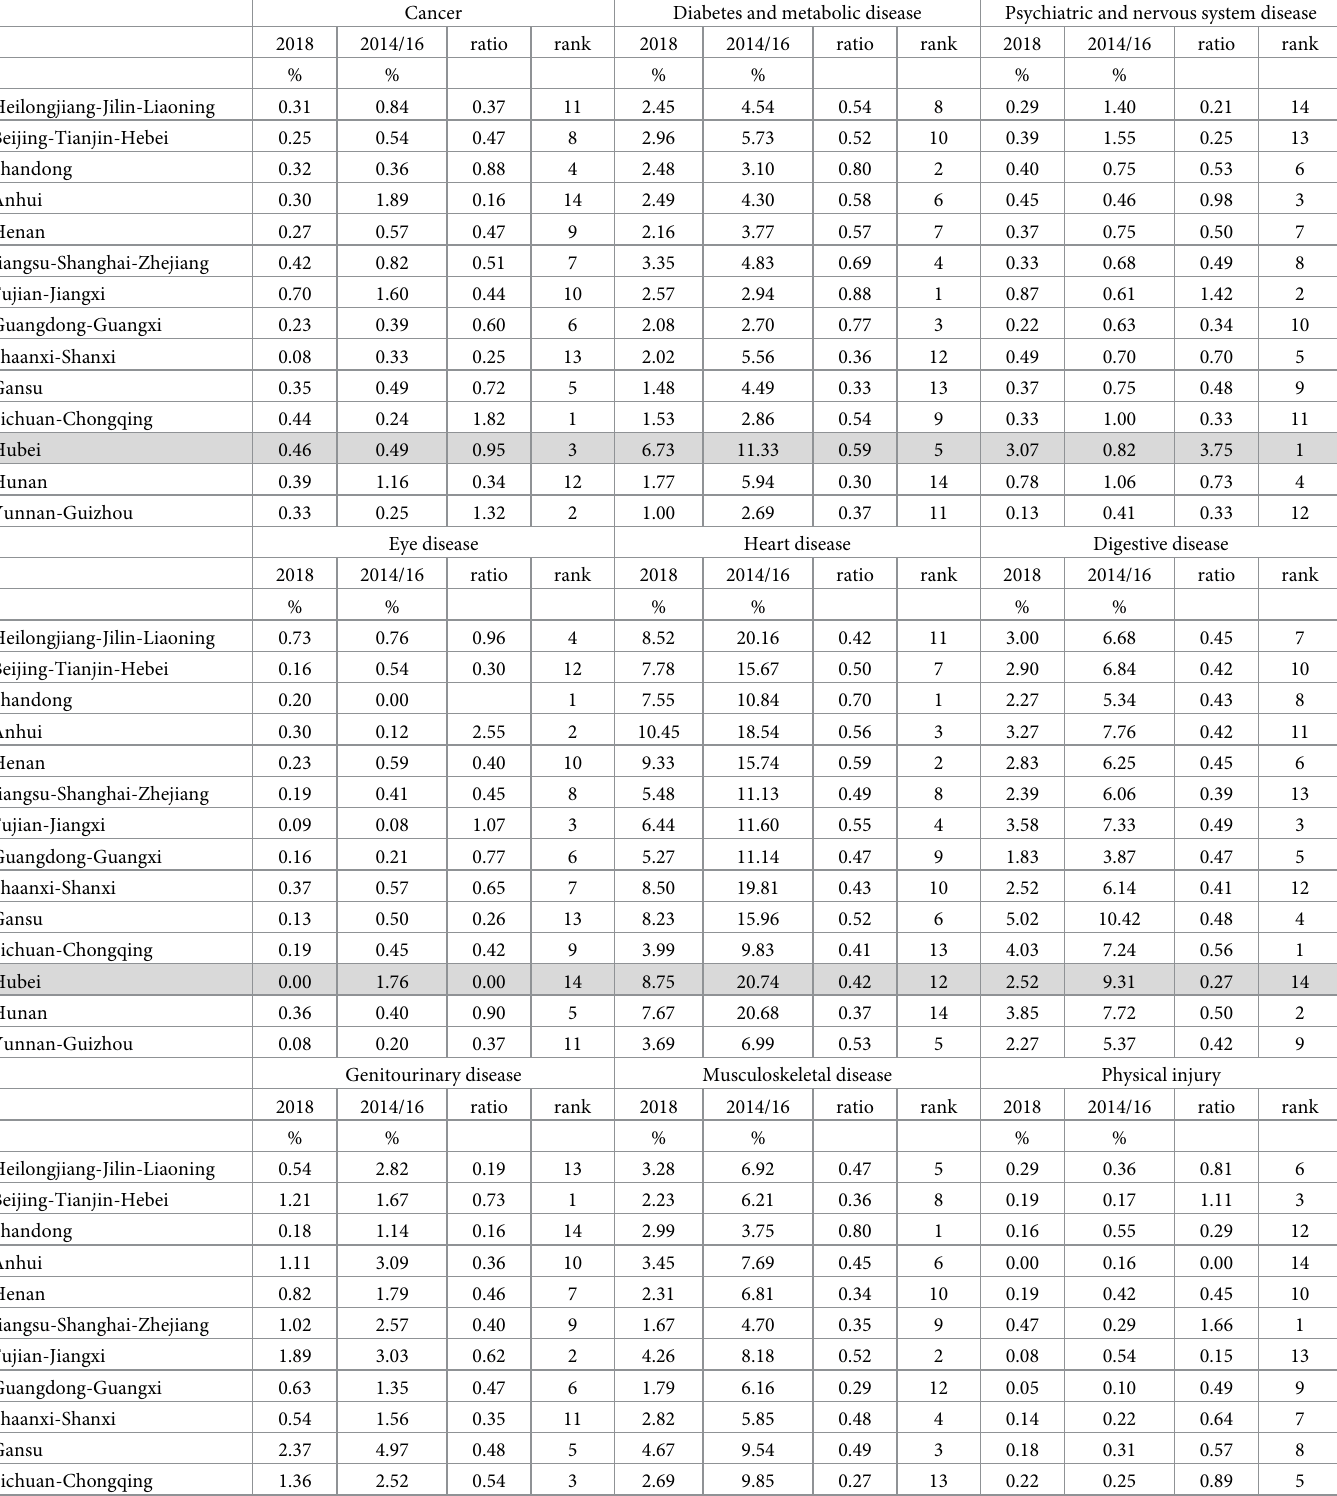
Table 2. Diagnosis of disease in past 6 months (CFPS). Cancer Diabetes and metabolic